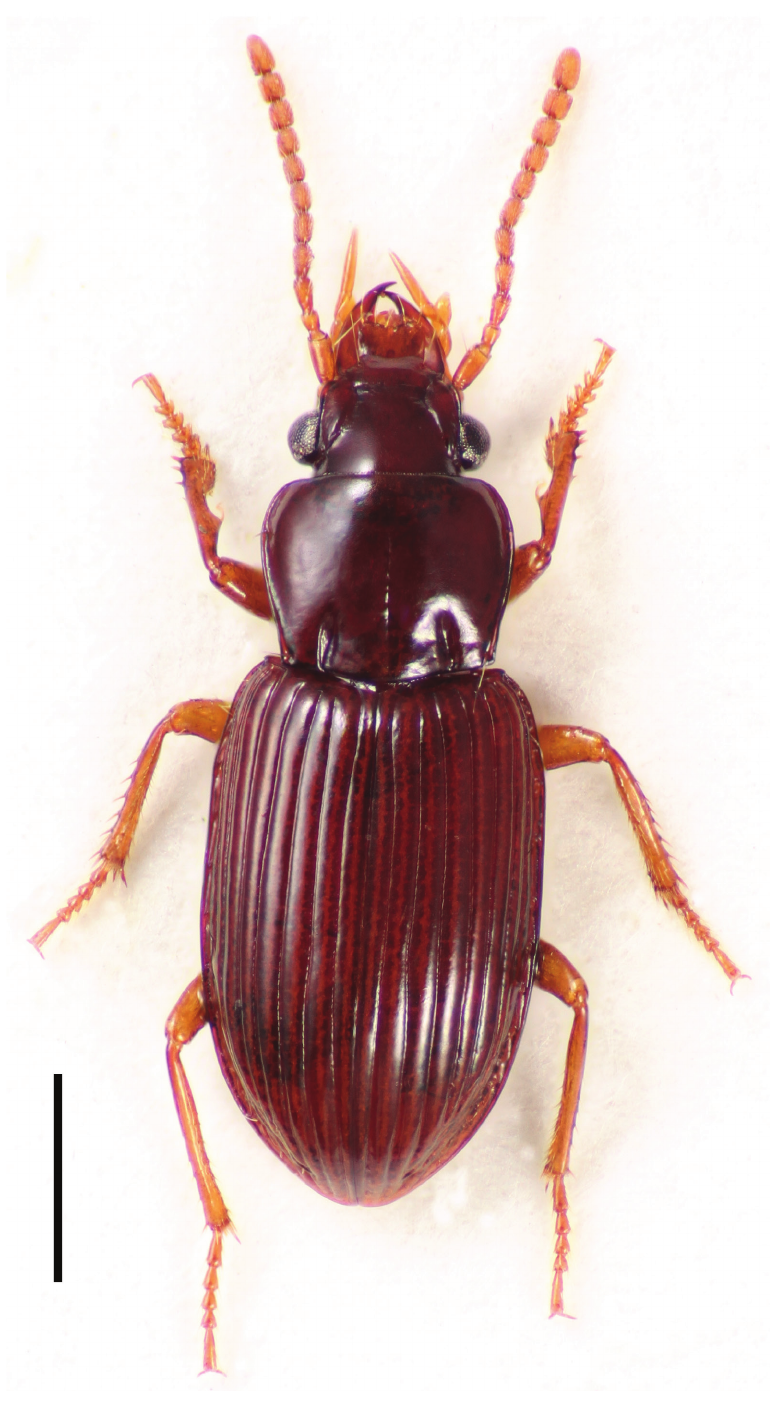
Figure 6. Dorsal habitus image of Cratocerus indupalmensis Grzymala & Will, sp. n. Scale bar = 1.0